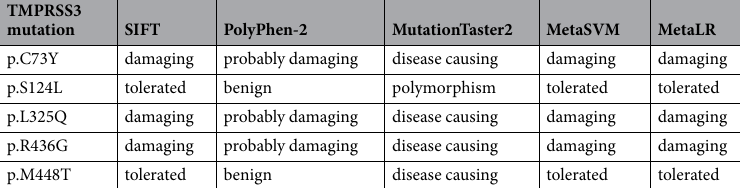
Table 4. Bioinformatics analysis of novel missense variants in TMPRSS3